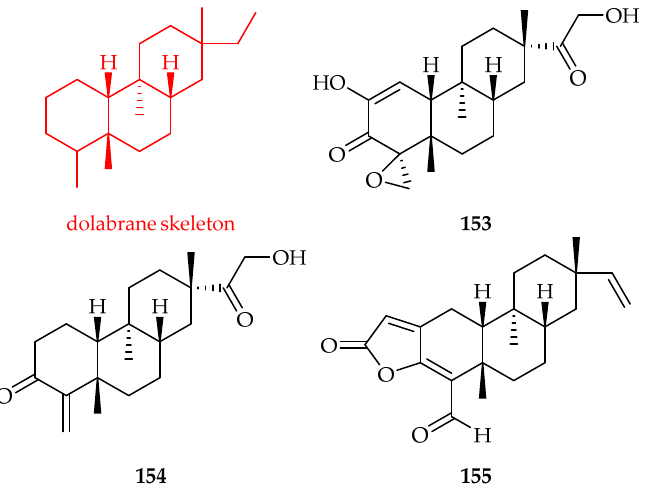
Figure 63. Structures of dolabrane skeleton, tagalene I 153 [97,99] tagalene K 154 [99], and tagalide A 155